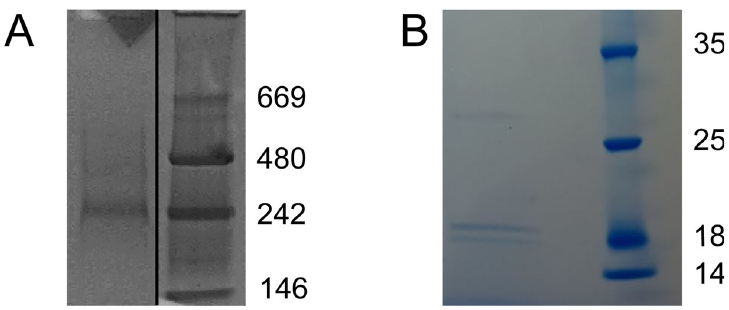
Fig 1. FLAP can be reconstituted into nanodiscs. (A) In the native gel, a band corresponding to purified FND (left lane) runs slightly slower than 242 kDa (see marker lane to the right) where END runs [11]. (B) A sample of FND denatured by SDS was loaded in the left lane and shows bands corresponding to MSP1E3D1 (29.9 kDa) and FLAP-C-His6 (18.5 kDa). To make the figure, relevant lanes were cut in the original gel image and rearranged in (A) and a section was cut out from the original gel image in (B), see S1 Raw images.